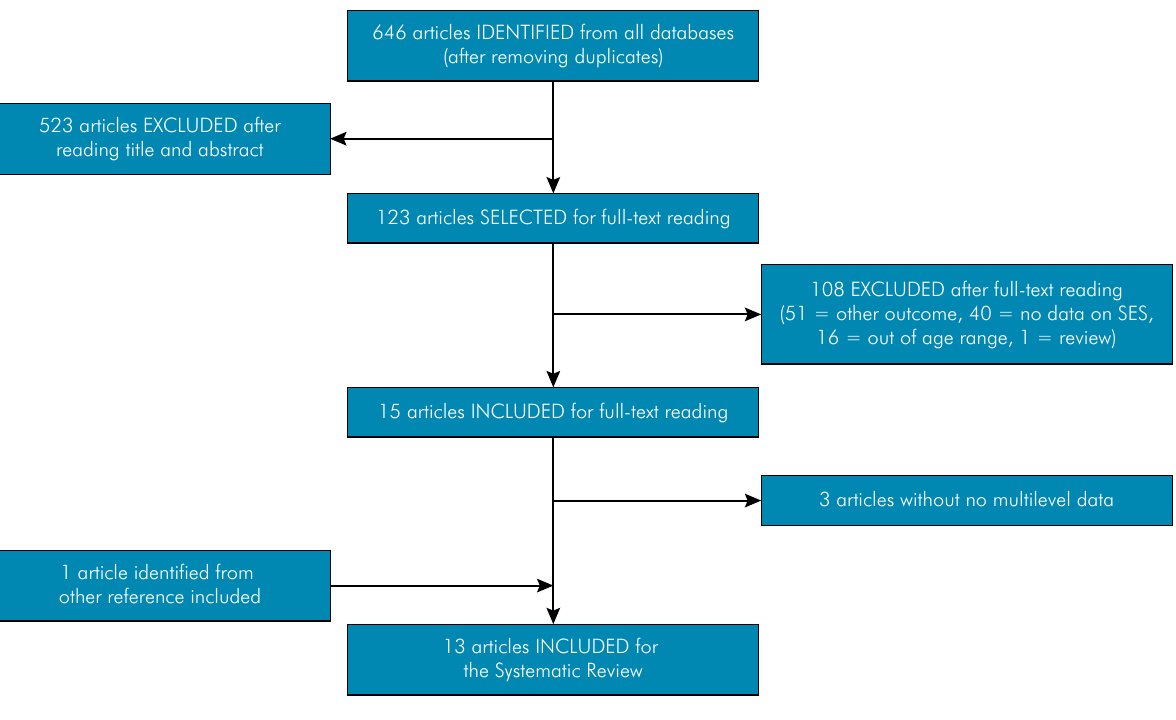
Figure 1. Flowchart outlining the search strategy and results along the